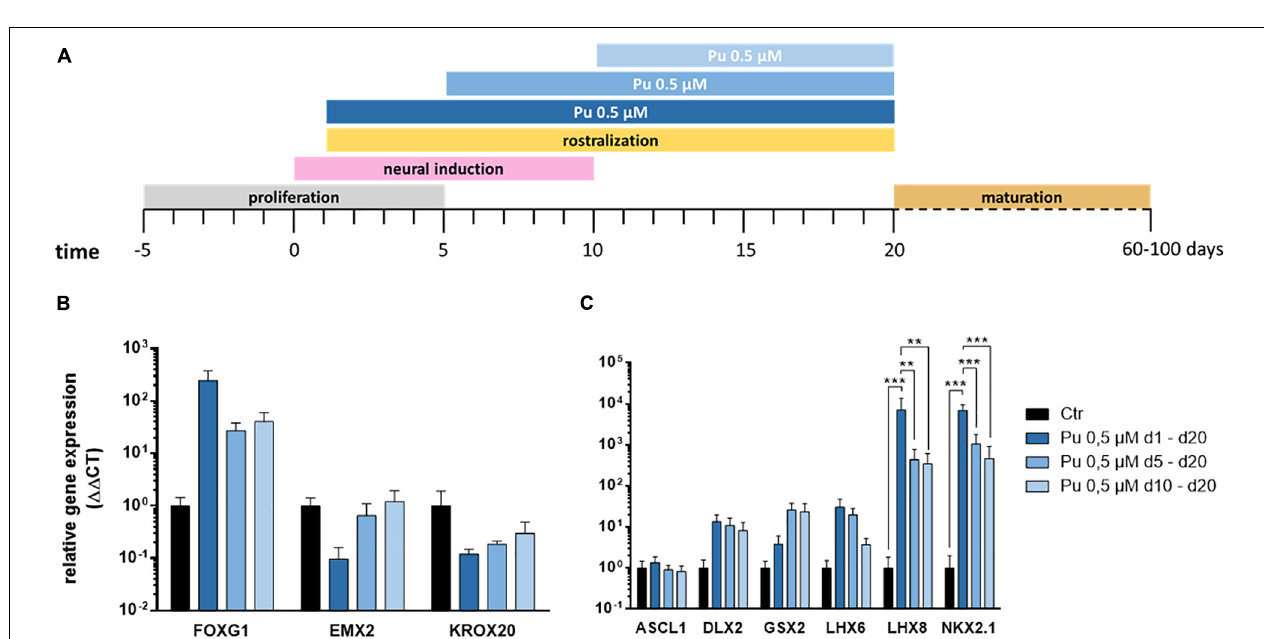
FIGURE 3 | Verification of the most effective ventralization morphogen. (A) Differentiation protocol. Gene expression analysis of either purmorphamine- or Sonic hedgehog-treated cells relative to non-treated samples along the rostro-caudal (B) and dorso-ventral (C) axis, at day 20; n = three to five differentiations, three hiPSC lines. Statistical analysis: two-way ANOVA, correction for multiple testing by the Tukey method, error bars depict the SEM. Significant with p -value < 0.05 (*).